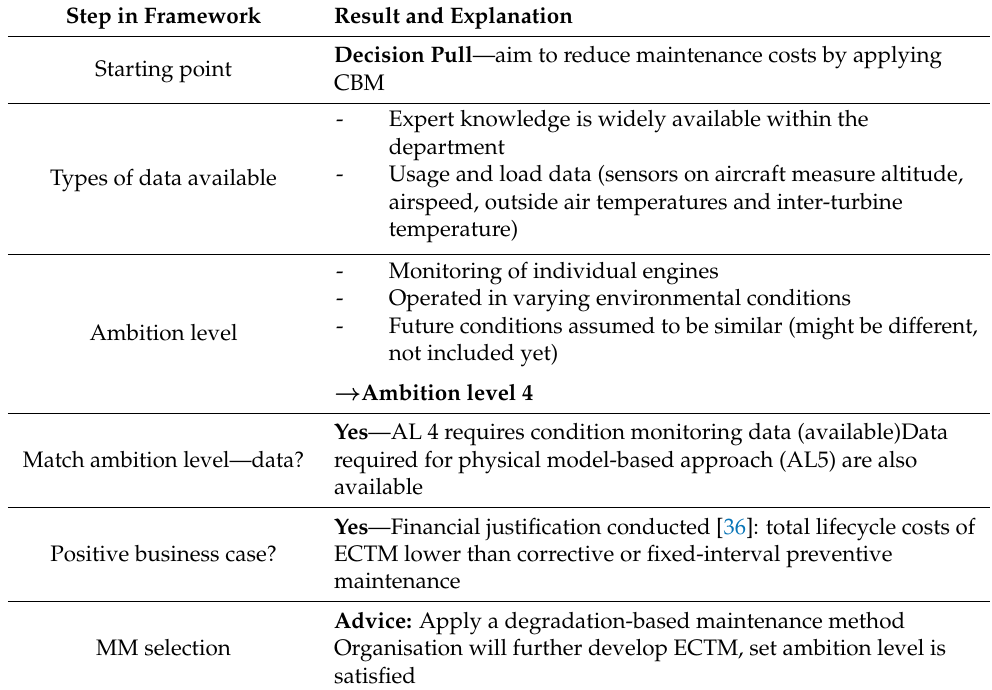
Table 5. Application of the decision framework to case